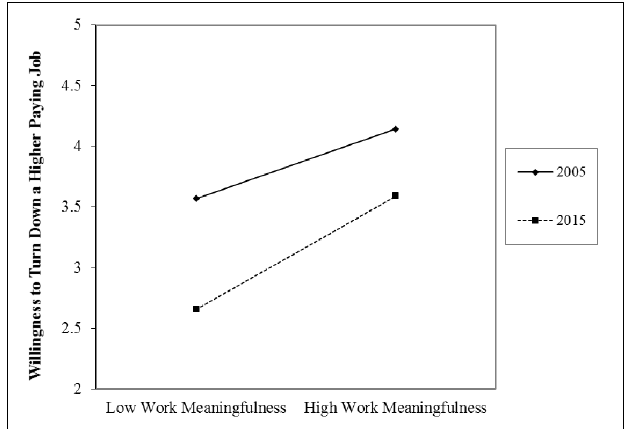
FIGURE 3 | The relationship between work meaningfulness and the willingness to turn down a higher paying job in 2005 and 2015.